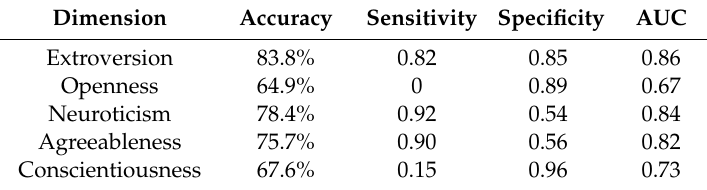
Table 2. Results for the high valence high arousal (HVHA) scenario. AUC, area under ROC curve.